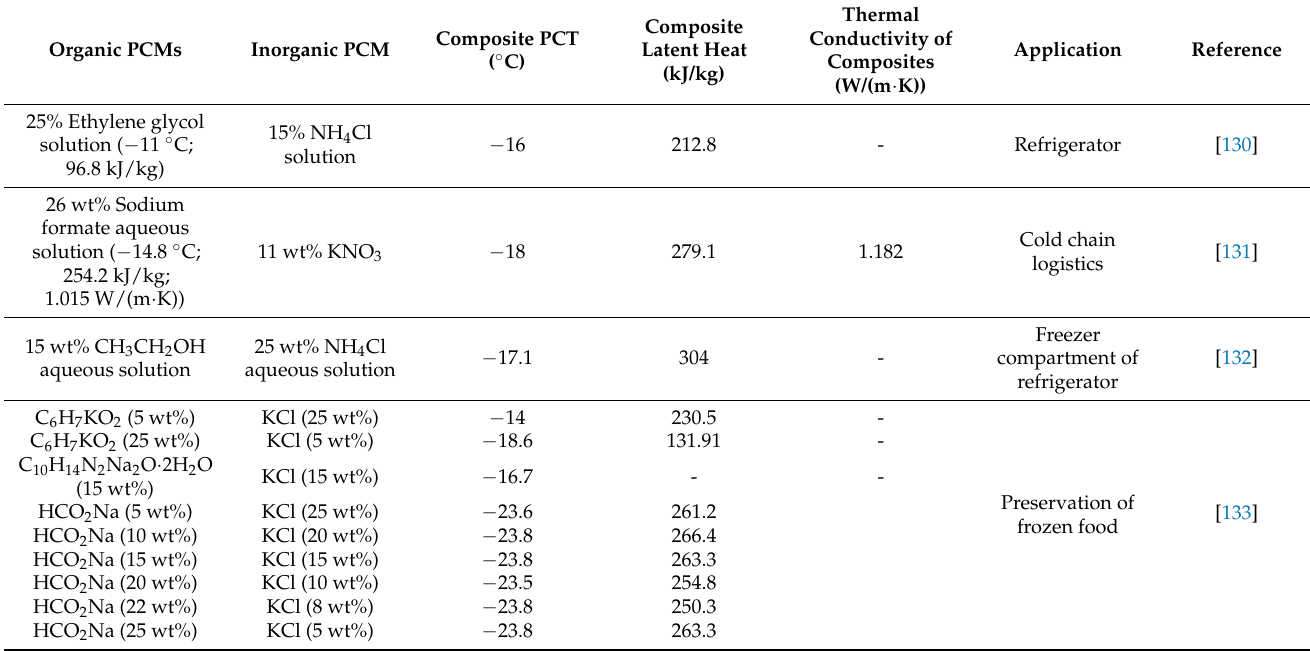
Table 9. A complex of organic and inorganic salt solutions for